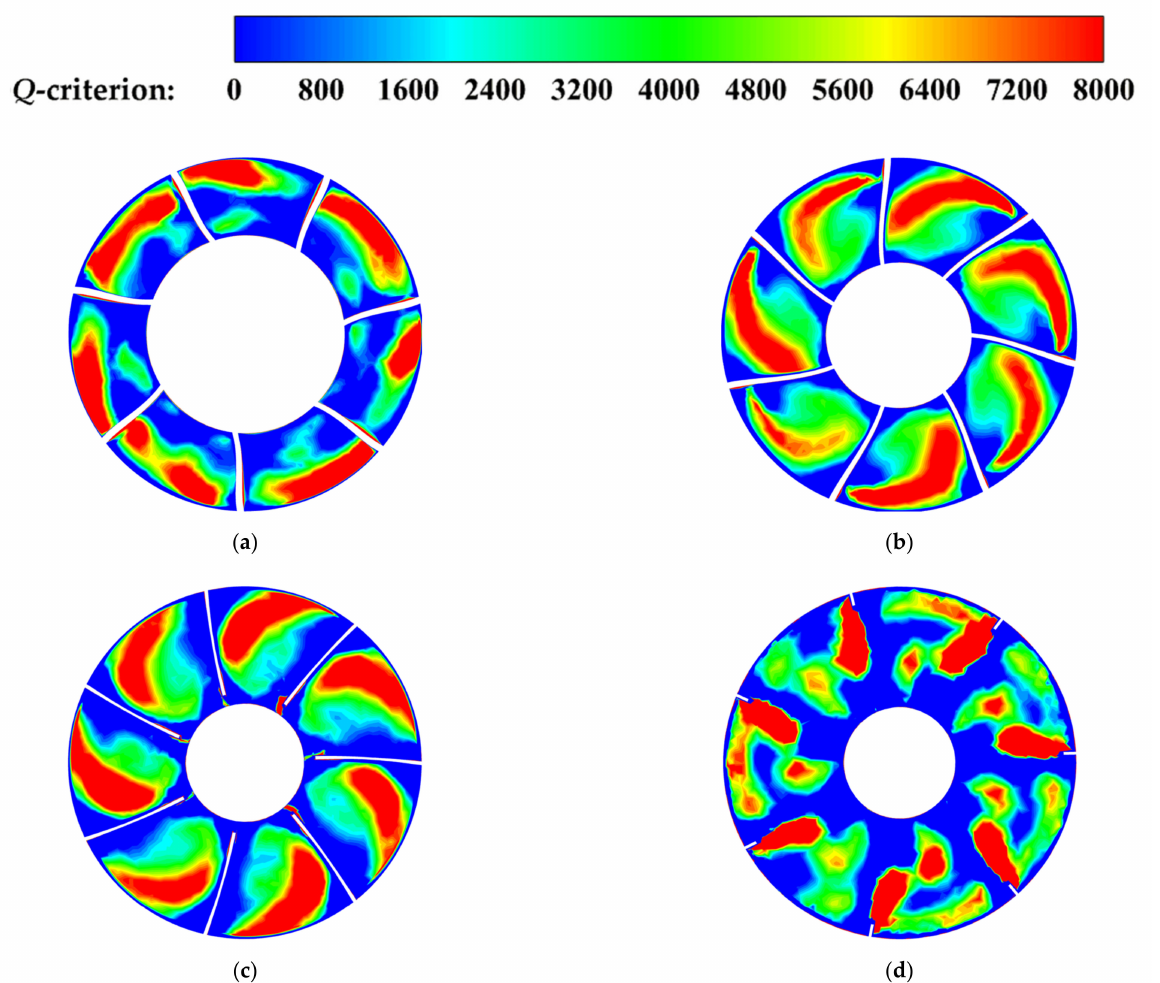
Figure 10. Vorticity distributions on different sections of guide vane. ( a ) One-third of guide vane; ( b ) Two-thirds of guide vane; ( c ) Five-sixths of guide vane; ( d ) Outlet of guide